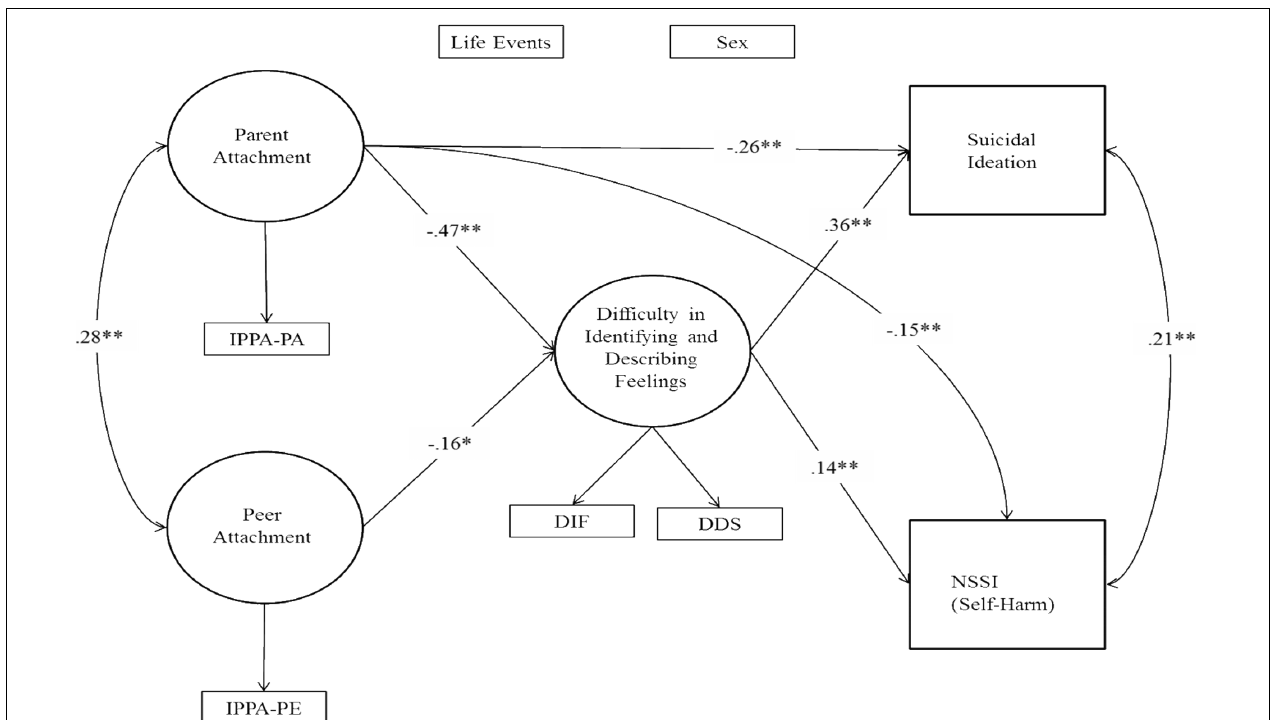
FIGURE 1 | Mediational model. Variance explained ( R 2 ). Difficulty in identifying and describing feelings ( R 2 = 0.434); suicidal ideation ( R 2 = 0.328); NSSI ( R 2 = 0.156). The effects of sex and stressful events were estimated but not depicted for the sake of simplicity.